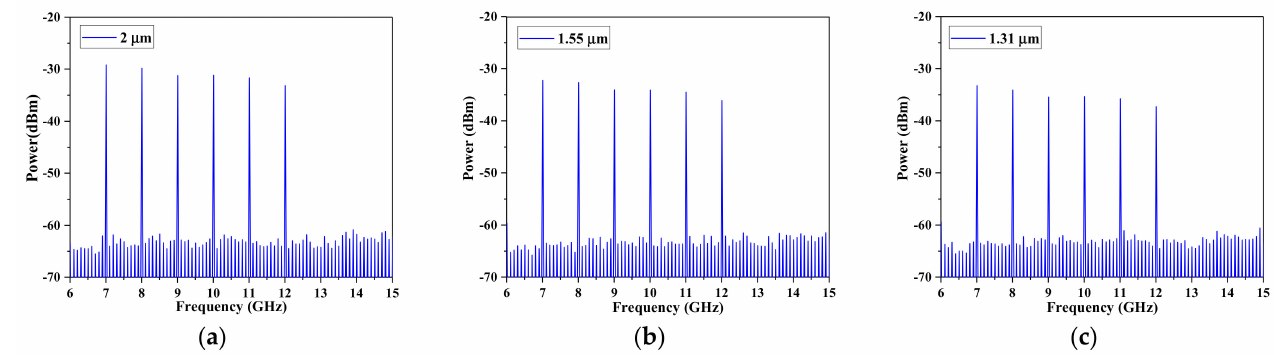
Figure 4. The generated 7–12 GHz tunable frequency-doubling microwave carriers after the DSB-CS